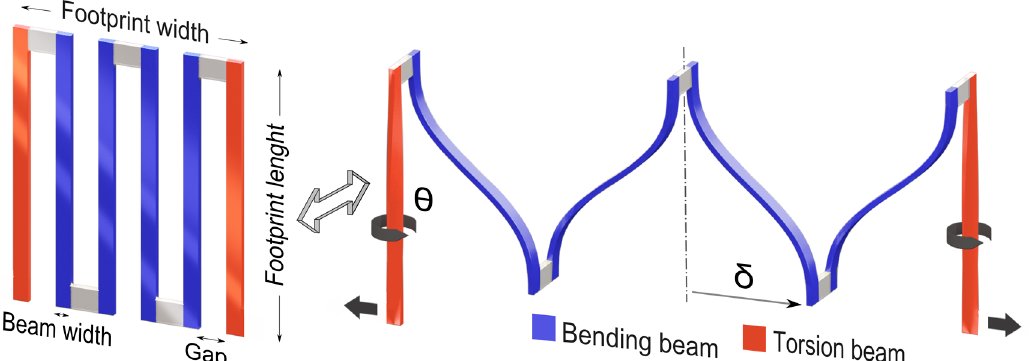
Figure 2. Concept illustration of the basic working principle of the free-standing interconnect design. ( Left ) Basic components of the design, with two torsion beams at the corners and multiple bending beams in the middle; ( right ) Basic deformation modes in the stretched state with the corner beams elastically rotated by 90 ◦ , which allows the inner beams to elastically bend in the direction of their thickness. δ and θ represent the tip deflection of the bending beam and the rotation angle of the torsion beam,